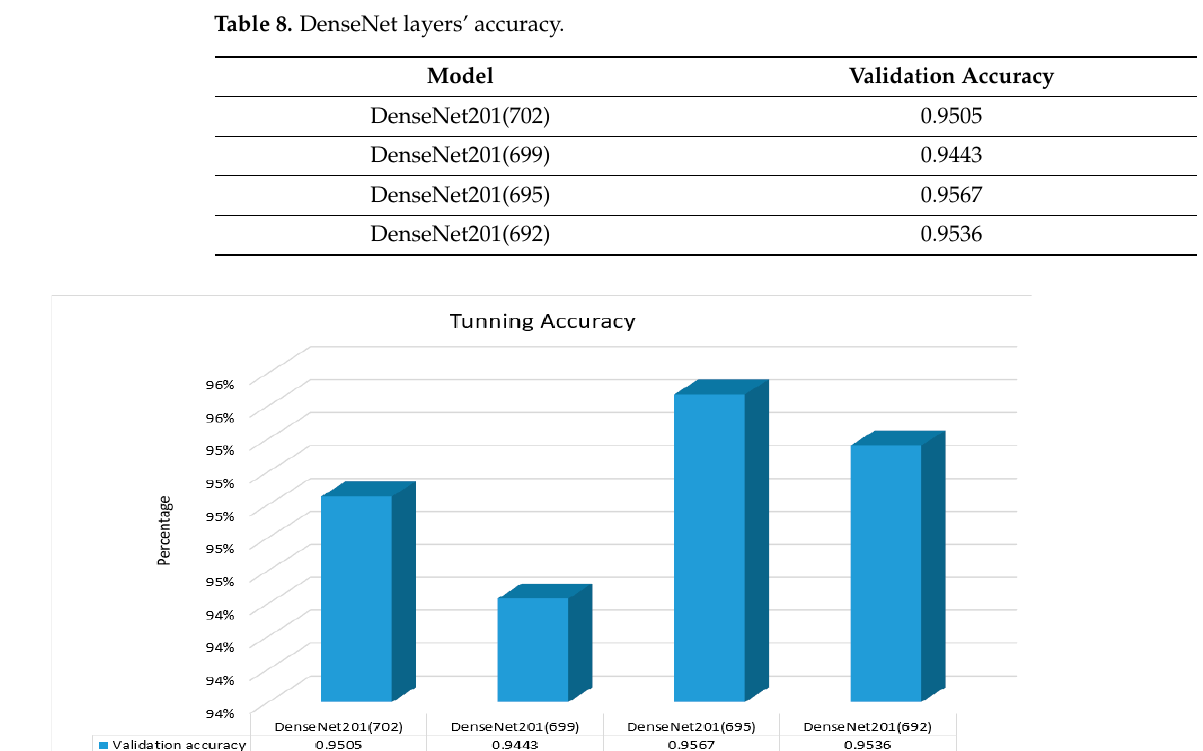
Figure 33. Tuning accuracy for different DenseNet layers.